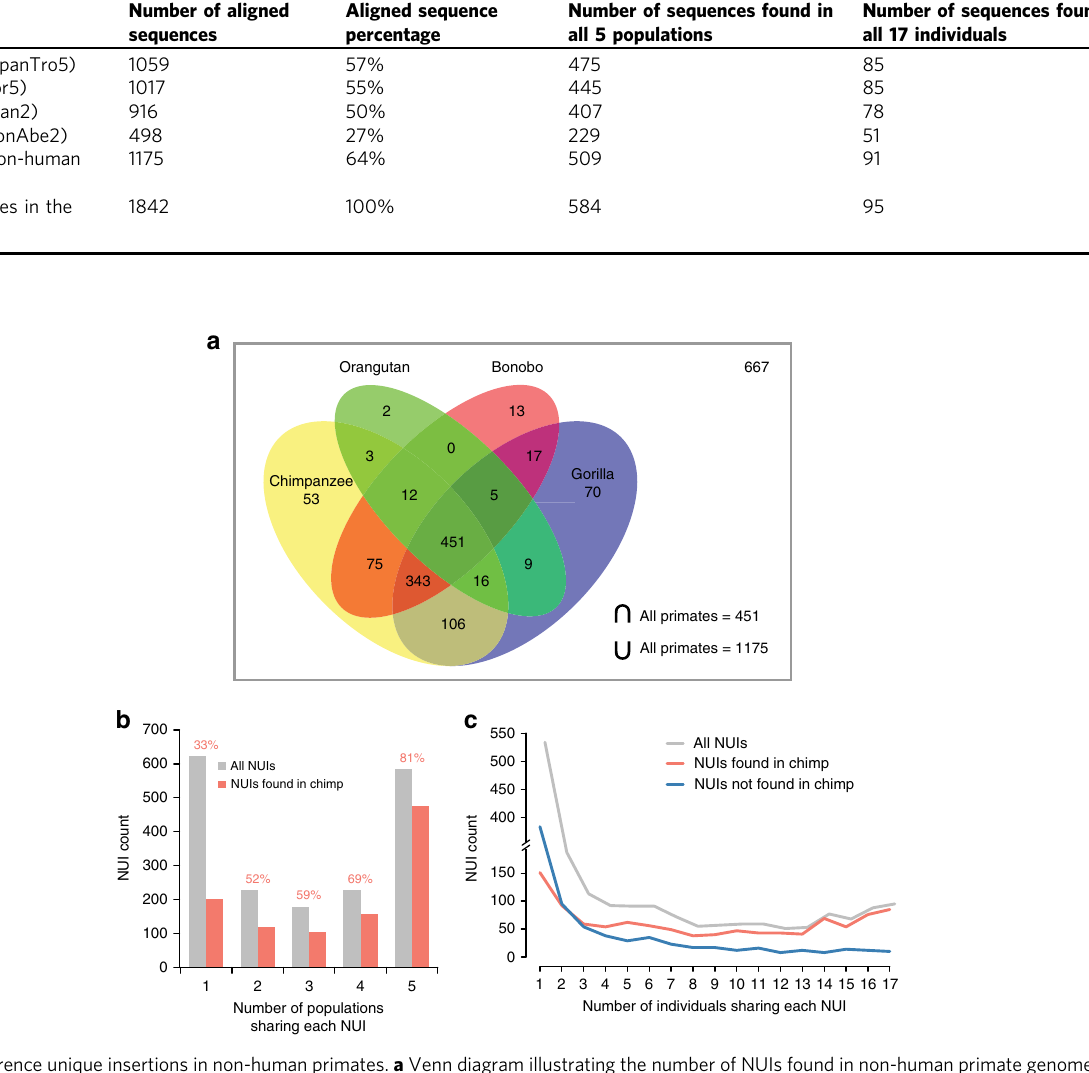
Table 2 Non-reference unique insertions identi fi cation in non-human primates Number of aligned sequences